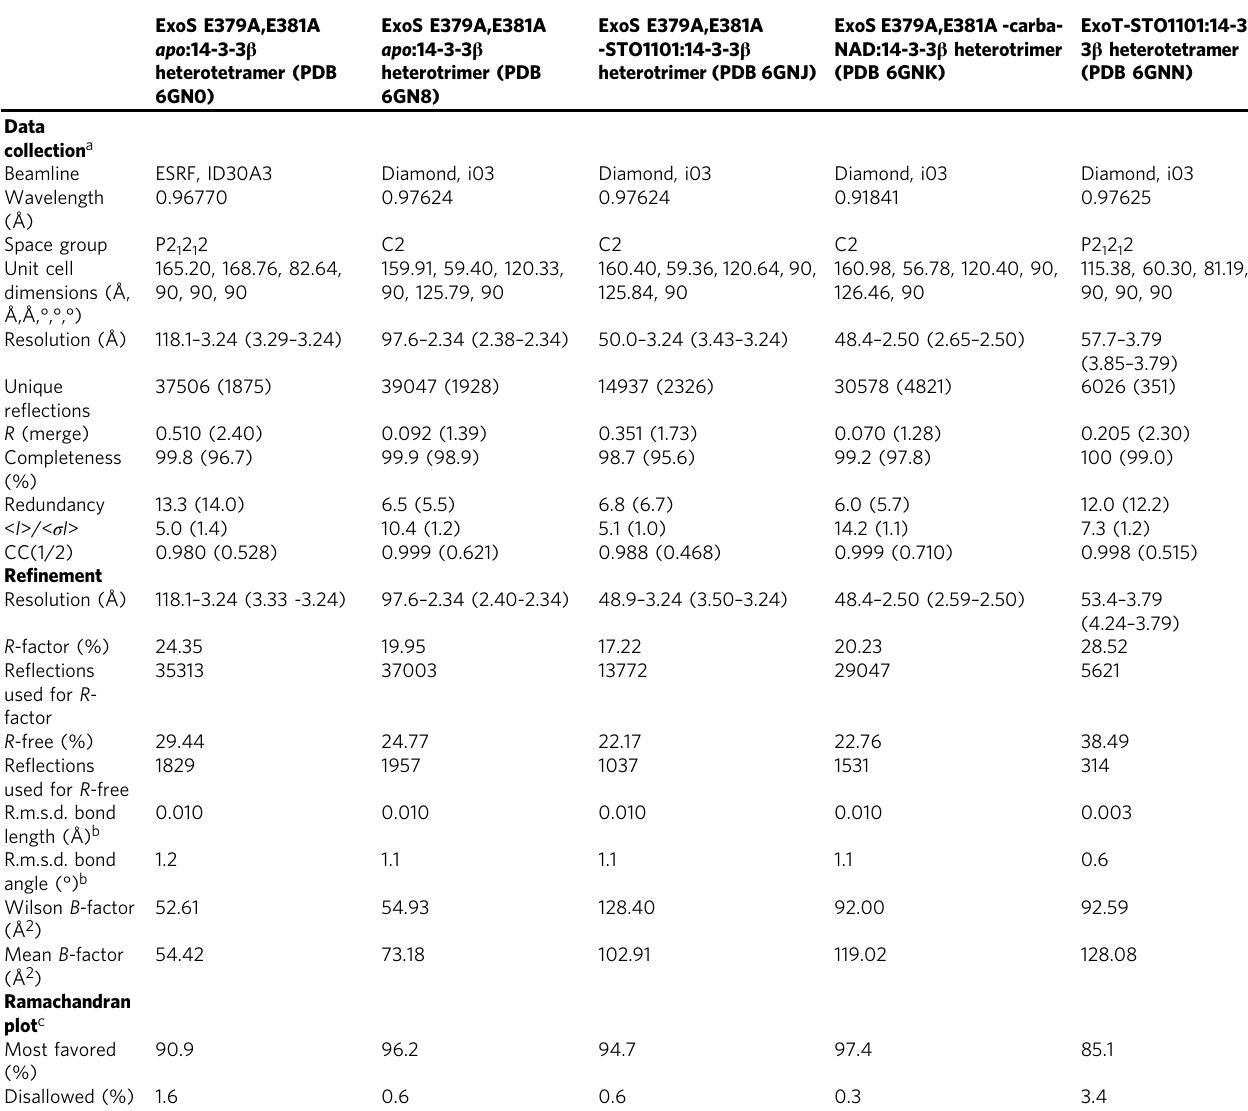
Table 1 Data collection and re fi nement